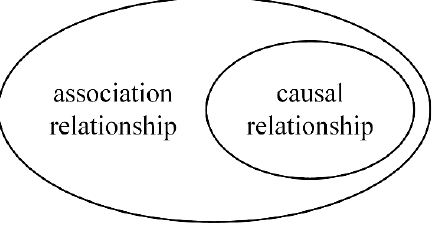
Figure 3. Association relationship and causal relationship.